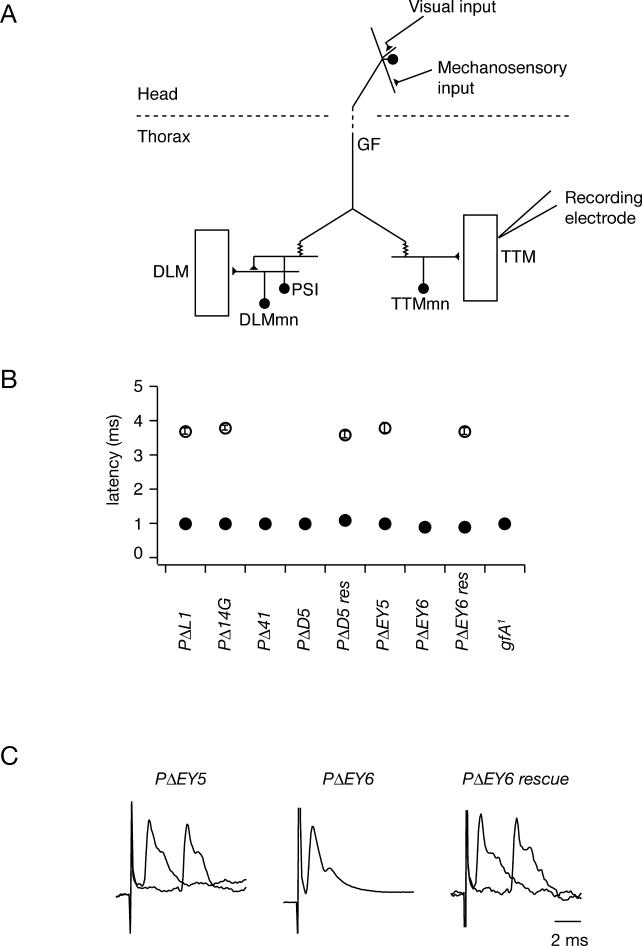
Long-Latency Response of TTM to Giant Fiber Stimulation(A) Recording configuration. The giant fiber was stimulated via tungsten electrodes in the eyes, and extracellular potentials were recorded from the TTM.(B) Average long- and short-latency response of TTM to giant fiber stimulation in different genotypes.PΔD5 rescue andPΔEY6 rescue had genotypesPΔD5/Y; UAS Dα7/c17 GAL4 andPΔEY6/Y; UAS Dα7/c17 GAL4, respectively. The success rate of long-latency stimulation was as follows:PΔL1 8/10,PΔ14G 2/4,PΔ41 0/5,PΔD5 0/6,PΔD5/Y; UAS Dα7/c17 GAL4 2/2,PΔEY5 4/6,PΔEY6 0/4,PΔEY6/Y; UAS Dα7/c17 GAL4 3/3,gfA1 0/3.(C) Representative traces showing the presence of short- and long-latency responses.PΔEY5 andPΔEY6/Y; UAS Dα7/c17 GAL4 showed both short- and long-latency TTM responses, but the long-latency response was absent inPΔEY6.